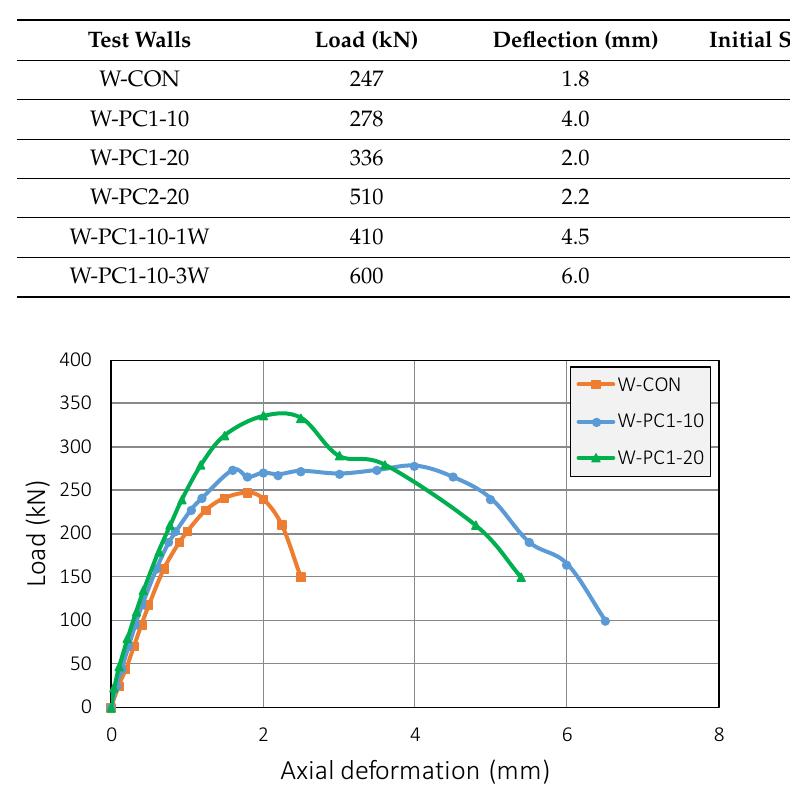
Figure 13. Experimental responses (Control and PC1 walls).